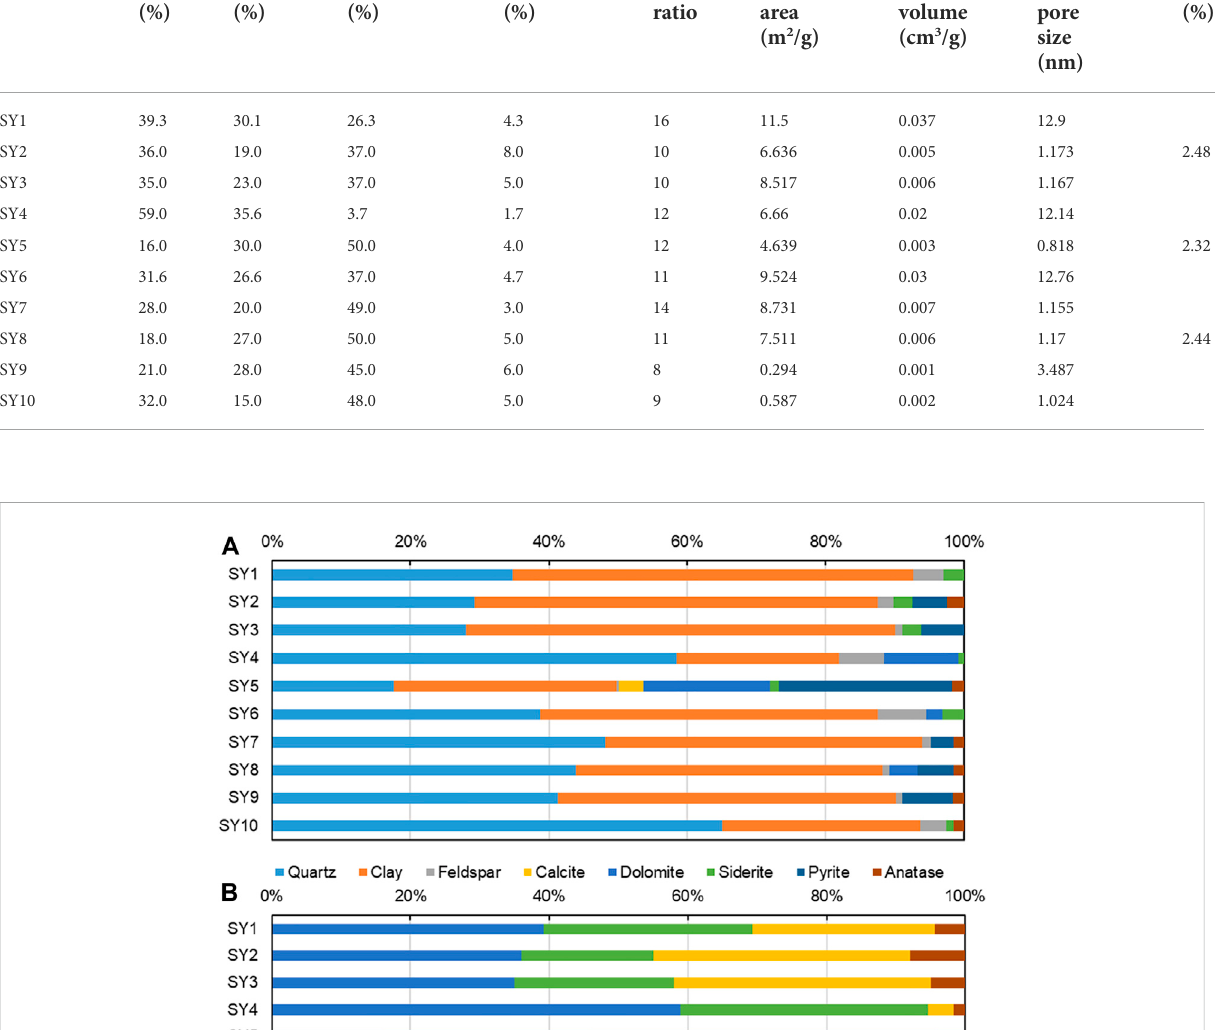
TABLE 2 Clay mineral composition, pore parameters, and Ro values of shale samples. Samples